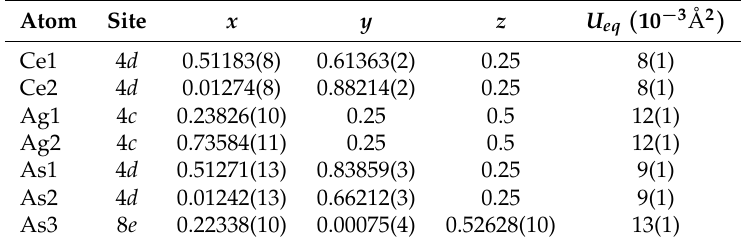
Table 2. Atomic coordinates and equivalent isotropic thermal displacement parameters for CeAgAs 2 . U eq is defined as one third of the trace of the orthogonalized U ij tensor. All atomic sites are fully occupied.